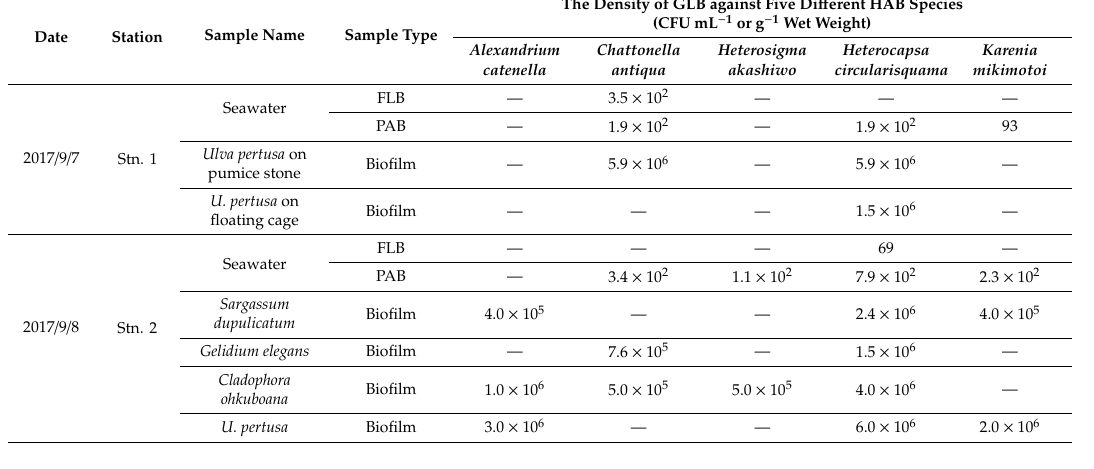
Table 2. Summary of growth-limiting bacteria (GLB) densities against five di ff erent harmful algal bloom (HAB) species estimated through co-culture experiments from seawater and macroalgal biofilms at Stns. 1 and 2.